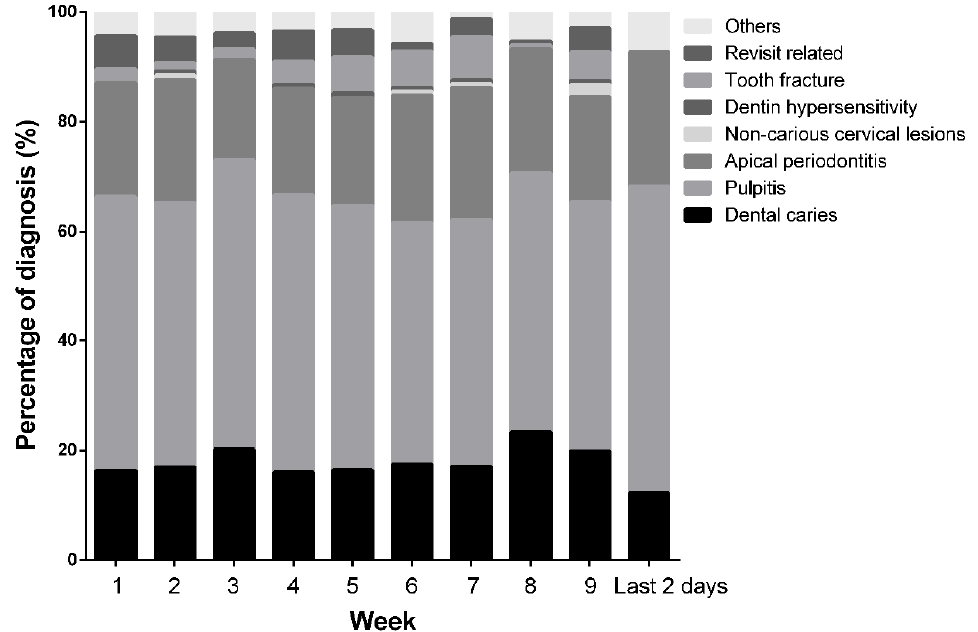
Figure 2. Stacked bar chart of the percentages of online diagnoses during the lockdown. After the lockdown, consultations surged from 23.15 ± 8.54 per day to 44.43 ± 12.63